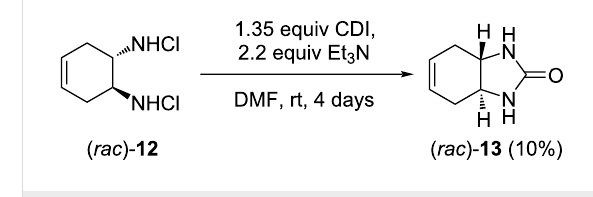
Scheme 7: Synthesis of the cyclic carbamide ( rac ) - 13